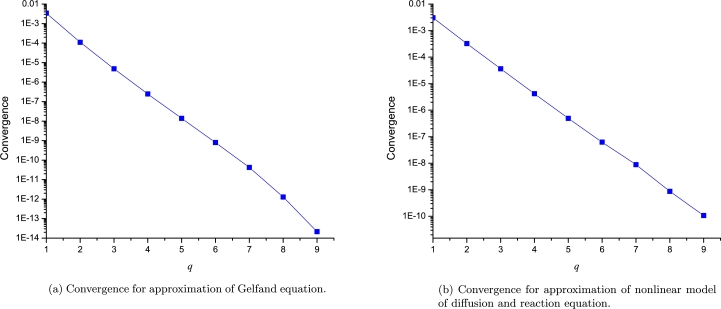
Computed convergence for both study cases.